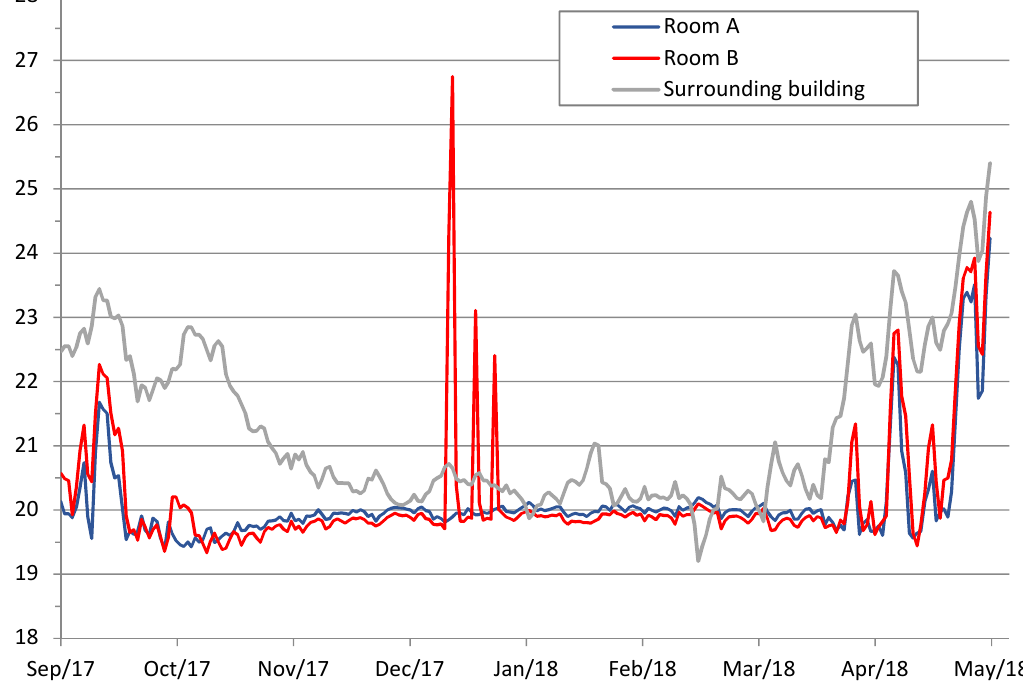
Figure 12. Temperature in test rooms (A and B) and in the surrounding building.